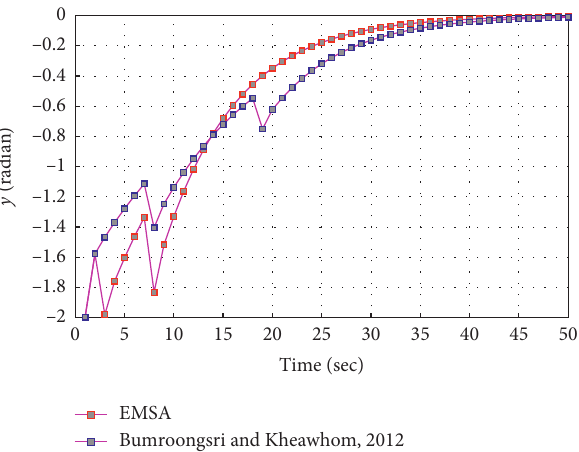
Figure 9: The control input obtained with EMPS approach. Table 4: Performance comparison with previous works.